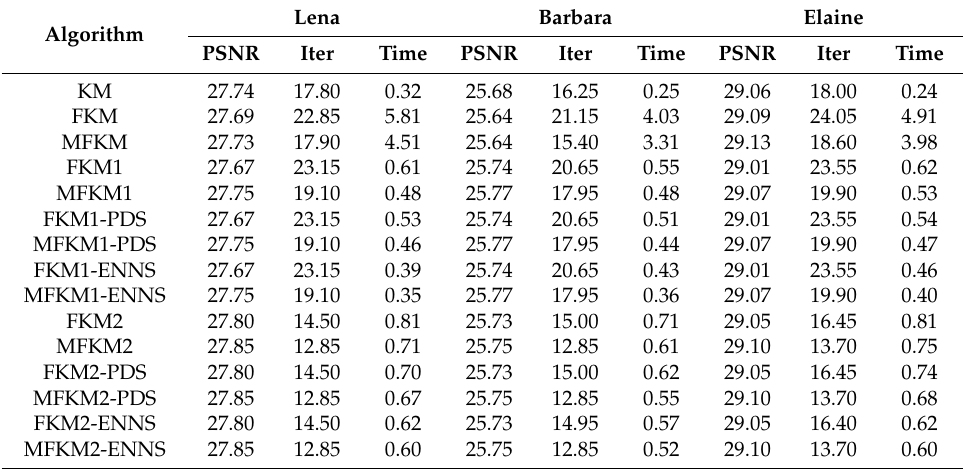
Table 4. PSNR (in dB), number of iterations and codebook design time (in seconds) for images Lena, Barbara and Elaine, using N = 64.